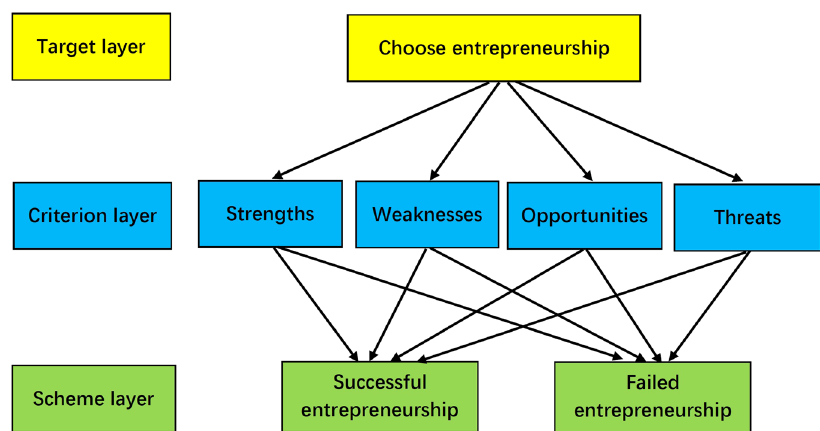
Fig. 1 Hierarchical structure of entrepreneurial ability of returning migrant workers. The target layer is the key problem to be solved by the decision, which is the choice of returning migrant workers to start business; the criterion layer is the main factors in fl uencing the migrant workers ’ entrepreneurship (SWOT elements); and the scheme layer is the development of suitable alternatives, which will directly determine the success or failure of the